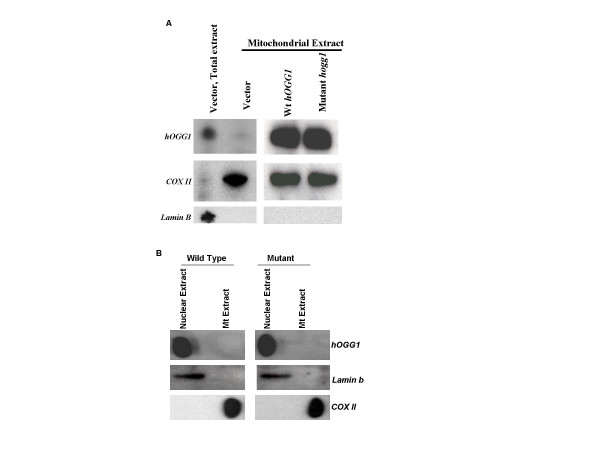
Expression of hOGG1 targeted to mitochondria. HeLa cells were transfected with empty vector, MTS-hOGG1, MTS-mutant-hogg1, Nuc-hOGG1, and Nuc-mutant-hogg1. Mitochondrial, nuclear and total cellular extracts were isolated and analyzed by Western blot analysis using anti-OGG1 antiserum. Twenty microgram of mitochondrial, nuclear and total cellular extract for each indicated transfection was loaded into each lane (Figure 2A. & B.). Protein extracts in each lane are as indicated. Immunodetection of Lamin B and COX II was done to assure that the transfected proteins were in nucleus and mitochondria respectively.